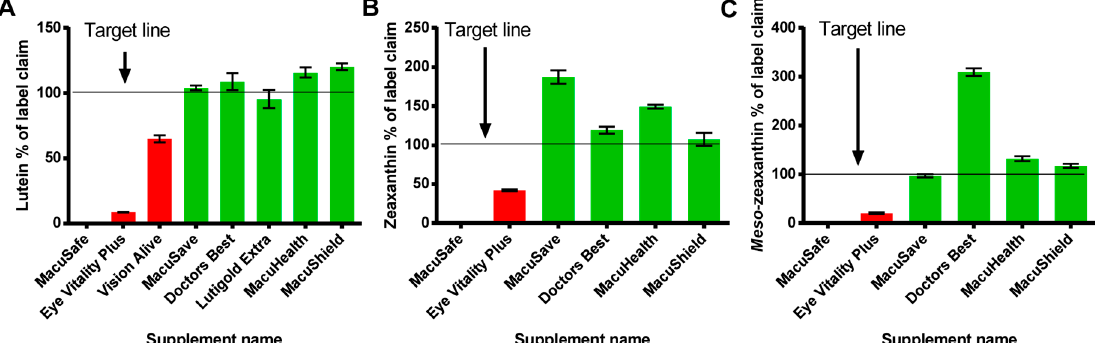
Figure 4. Second time point analysis illustrating concentration of L ( A ) Z ( B ) and MZ ( C ) expressed as a % of label claim for each product analysed (powder filled capsules are in red, oil filled capsules are in green). Vision Alive and Lutigold products are not shown in ( B ) and ( C ) as these products made no label claim regarding the concentration of Z and MZ. All supplements were analysed in triplicate.